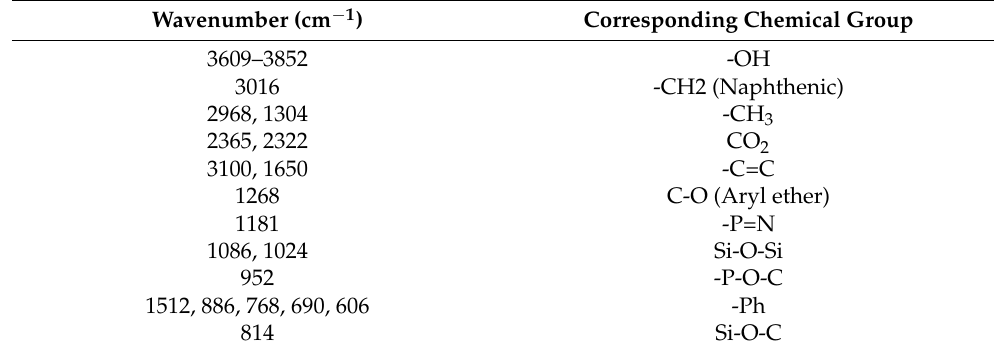
Figure 10. TG-FTIR-GCMS tests of HPCTP-0 and HPCTP-25 under nitrogen atmosphere: ( a ) TG- DTG curves of HPCTP-0 and HPCTP-25; ( b ) infrared spectra of gases that released from HPCTP-0 and HPCTP-25 at different temperatures; distribution of volatile gases at different temperatures: ( c ) HPCTP-0; ( d ) HPCTP-25; three-dimensional infrared spectra of the released gases: ( e ) HPCTP-0, ( f ) HPCTP-25. Table 4. Relationship between infrared spectrum and corresponding group in TG-FTIR-GCMS